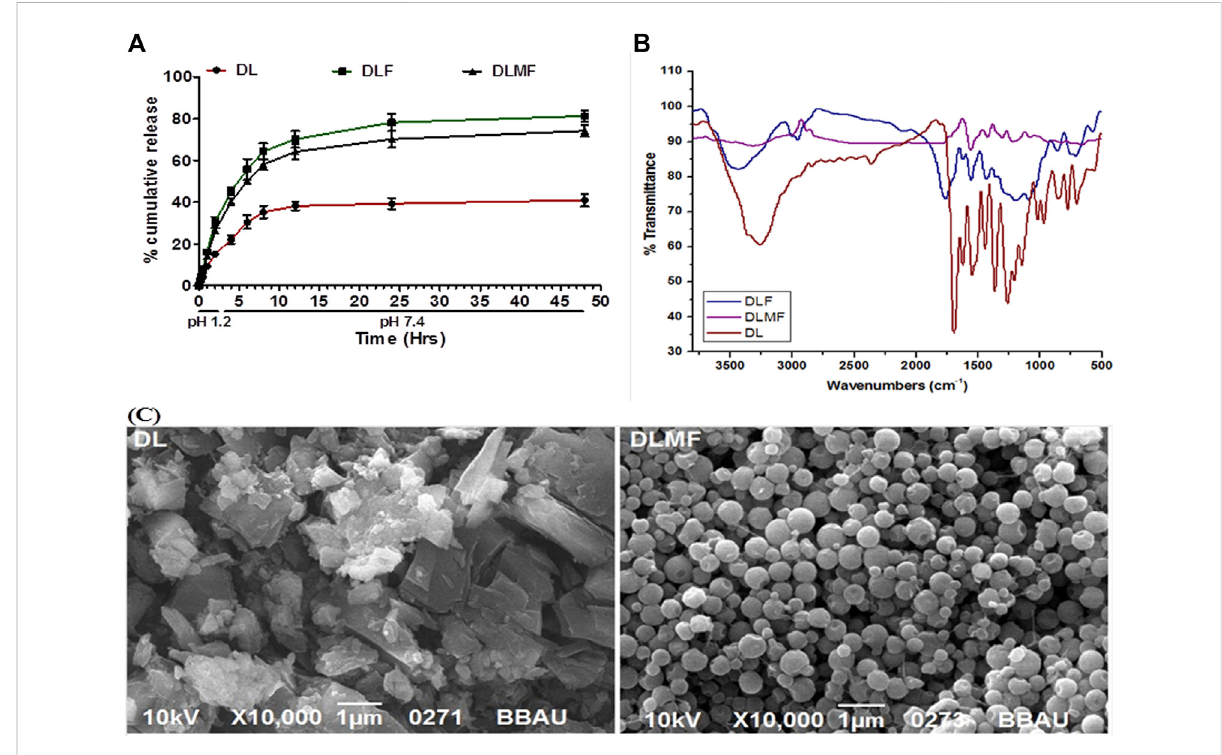
FIGURE 3 (A) In vitro release pro fi le of DL, DLF and DLMF, Results are expressed as mean ± SD ( n = 3). (B) FTIR spectrum of DL, DLF and DLMF. (C) SEM images of DL and DLMF.